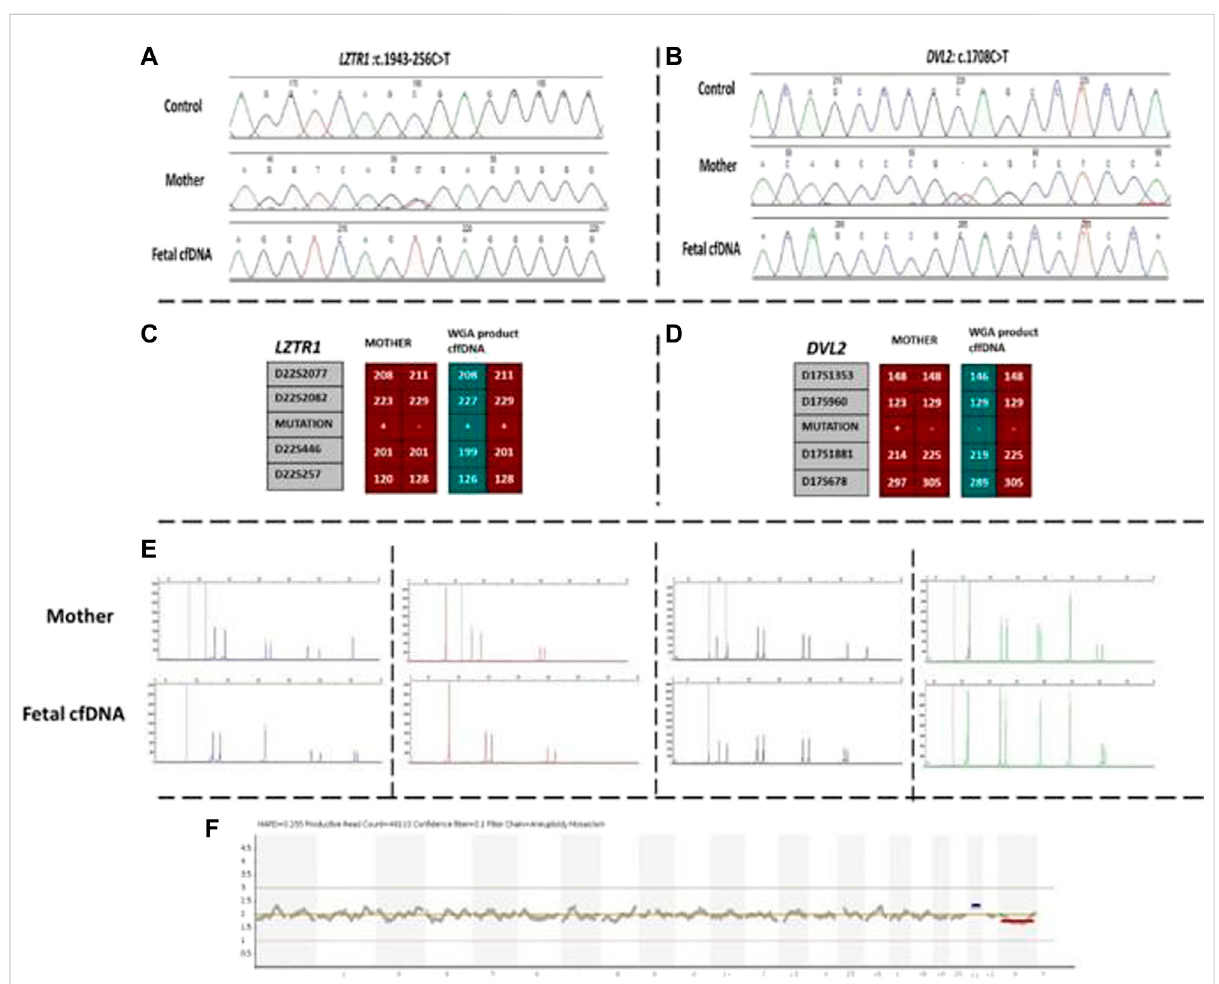
FIGURE 1 Findings of case 1. (A) Sanger results for LZTR1 gene for mother and WGA product of cffDNA. (B) Sanger results for DVL2 gene for mother and WGA product of cffDNA. (C,D) Karyomaps comparison for LZTR1 and DVL2 , respectively. (E) AmpFLSTR ™ Identi fi ler ™ Plus kit results for the mother and WGA product of cffDNA to detect maternal interference. (F) Ion reporter genome viewer for the WGA product of the cffDNA showing the high risk of trisomy 21 in the male fetus. cffDNA, cell-free fetal DNA; WGA, Whole-genome ampli fi